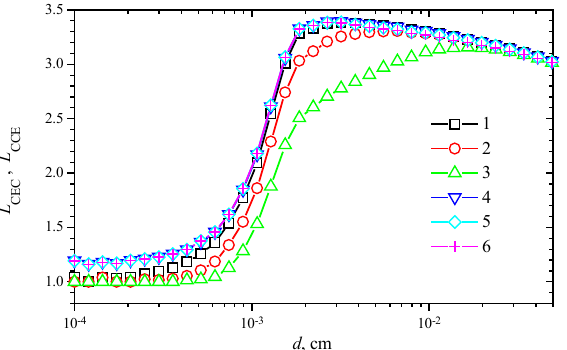
(1-3) and L (4-6) versus the membrane thickness d . CEC CCE